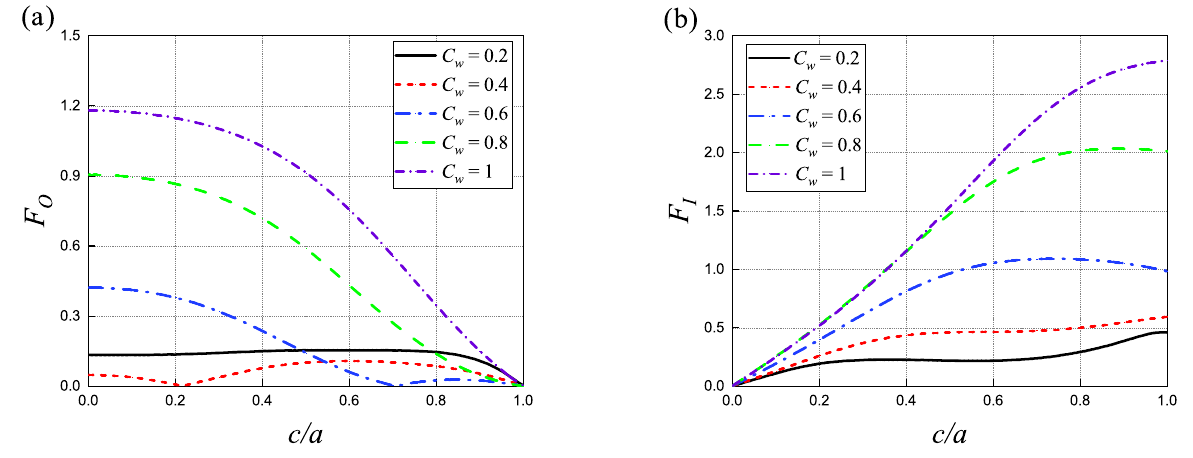
Figure 9. Hydrodynamic forces on the outer cylinder and the inner cylinders versus c / a for different wave-effect parameters C w with e / a = 1, G 1 = 1, β = 0, and h / a = 1.5 : ( a ) the outer cylinder, ( b ) the inner